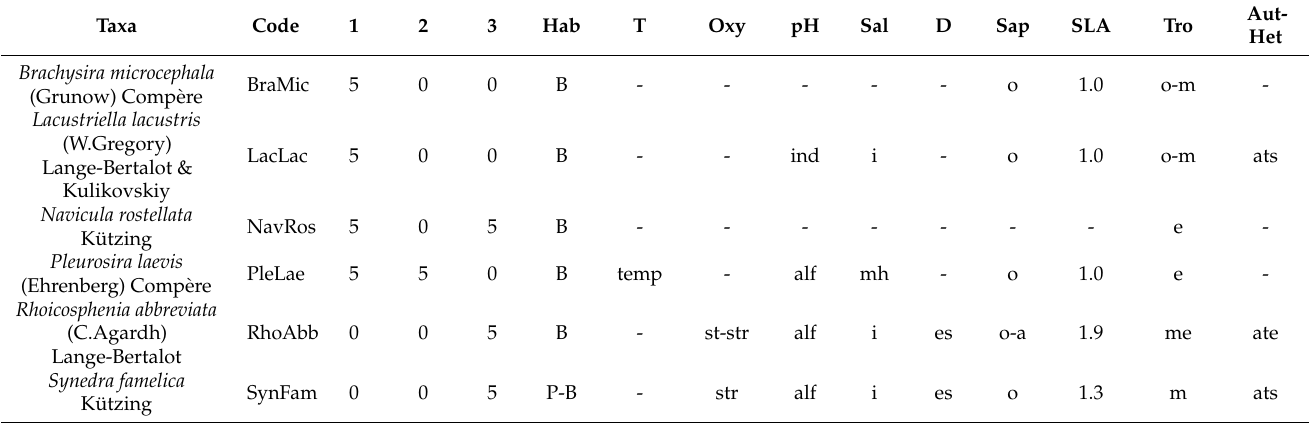
Table 6. Abundant taxa from three upper sites (1-2-3) with coded names, abundance scores and indicator properties.